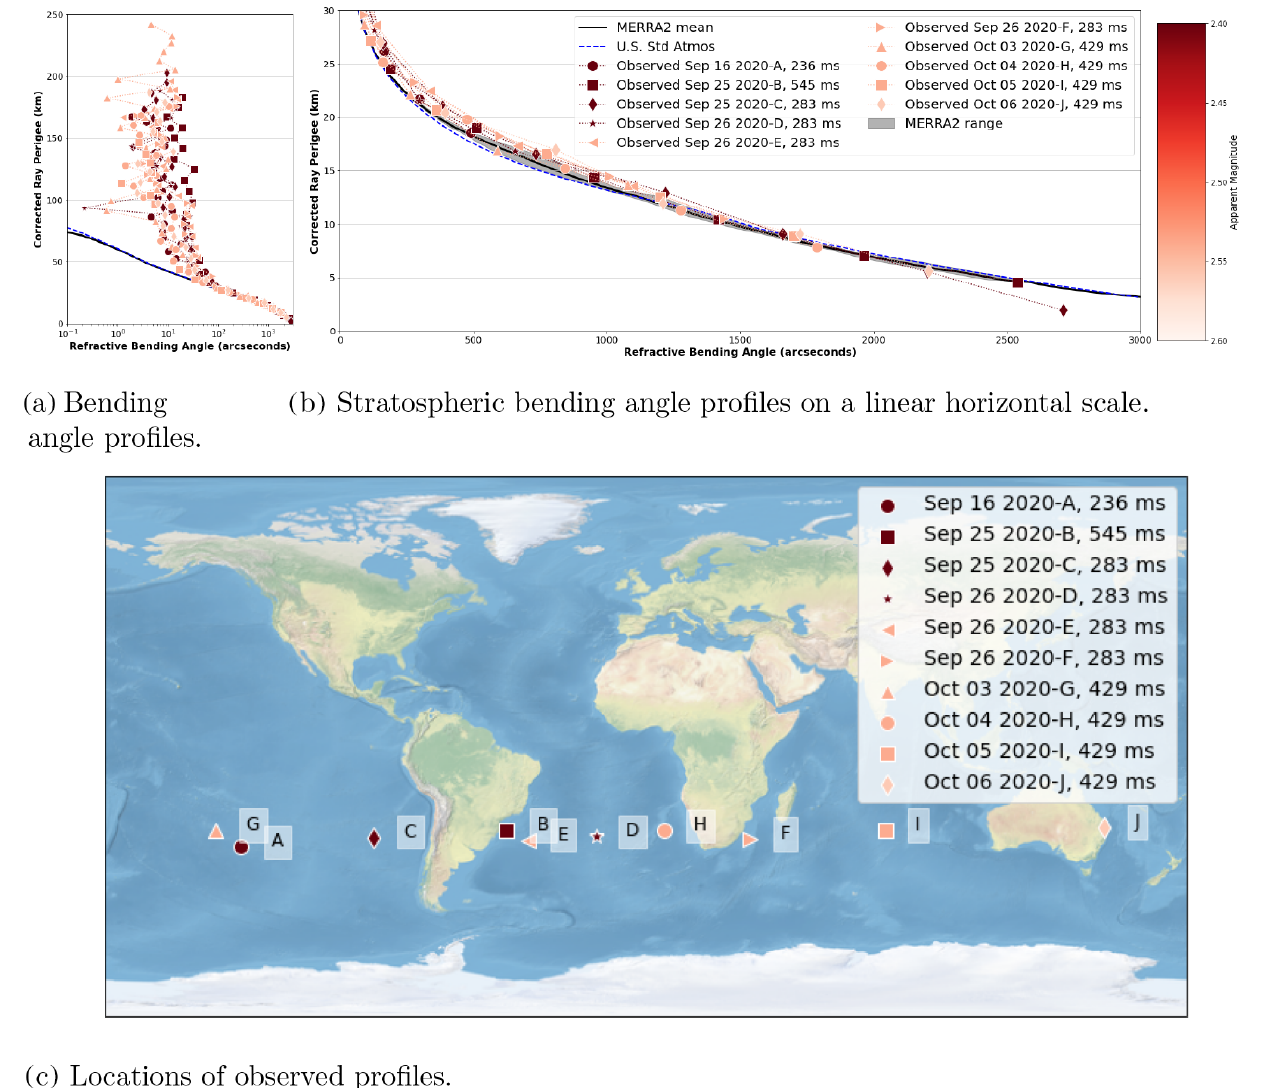
Figure 3. ST observations compared to MERRA2 and US Standard Atmosphere in panels (a) and (b) and their locations in panel (c) . The gray region is the range of bending angles from MERRA2 across all of our observations. The color of each observation dataset corresponds to the color bar showing apparent magnitude of the star captured from dimmest (2.6) to brightest (2.4). Panel (a) shows the full atmospheric sounding on a logarithmic scale, and (b) shows the profile in the stratosphere on a linear scale. The exposure time of each session’s images is listed in the legend entry.